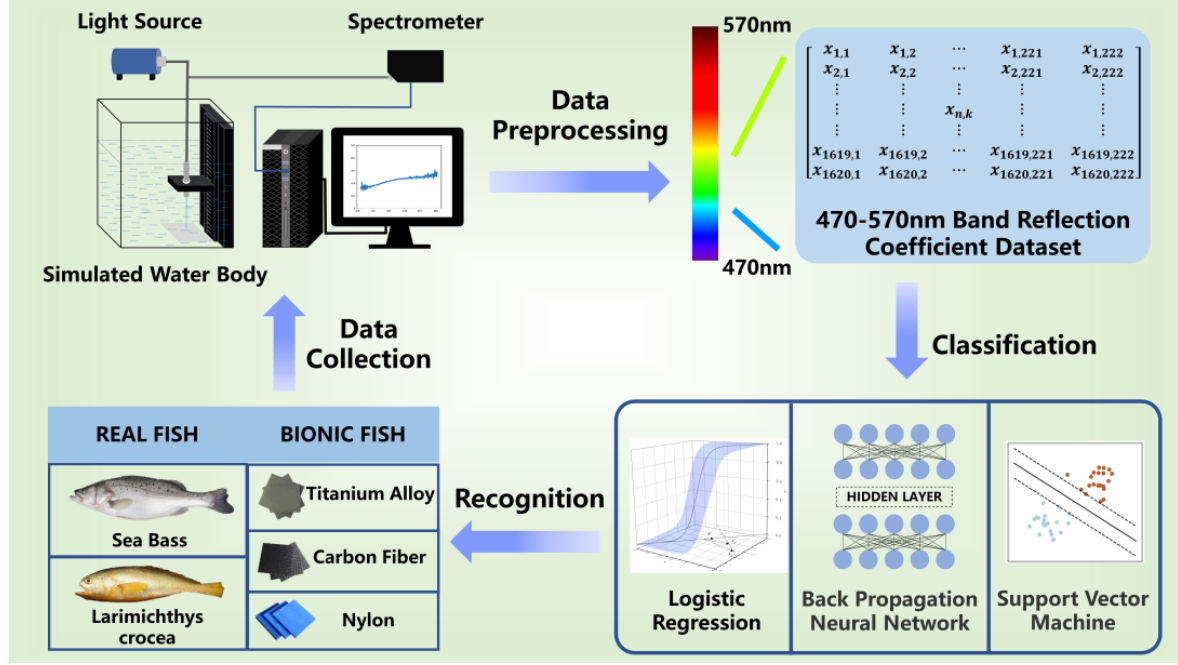
Figure 1. Schematic diagram of the whole process. The lower left shows the real fishes species and materials representing underwater bionic fishes we selected. On the upper left is the data acquisition device we built. The underwater Y-type optical fiber connects the spectrometer and the tungsten halogen lamp light source. The optical fiber head probing into the water is the transmitting end and receiving end of the light. The sliding platform fixing the optical fiber head is provided with a scale, which can read the light propagation distance. The data set we built is shown on the upper right, with a total of 1620 groups of data recorded to form the data set. The lower right are the machine learning methods we selected to verify the validity of the data set.